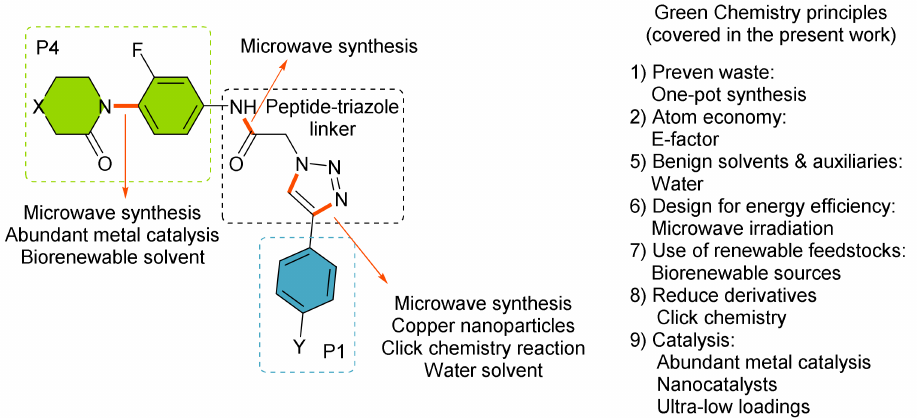
Figure 3. General structure of the molecules designed from this work.